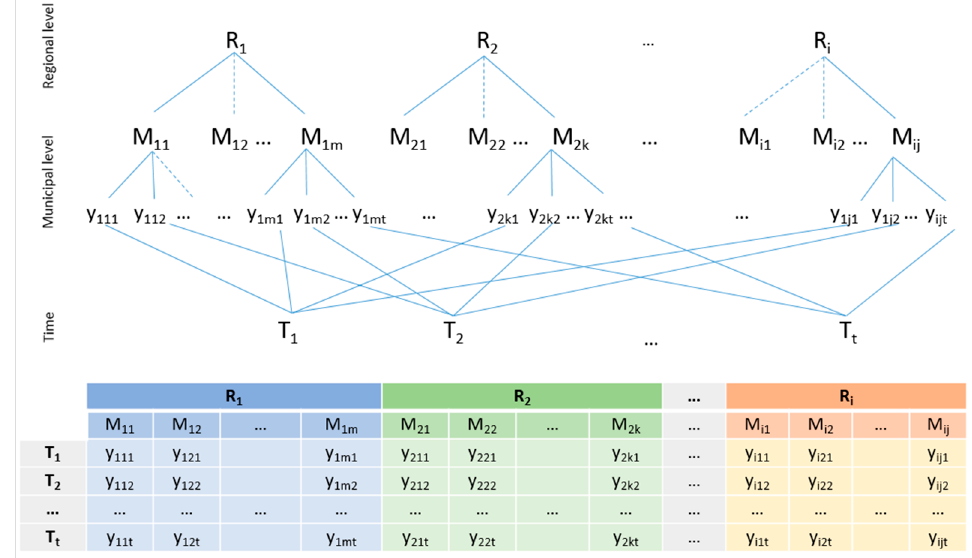
Figure 1. Configuration of data.